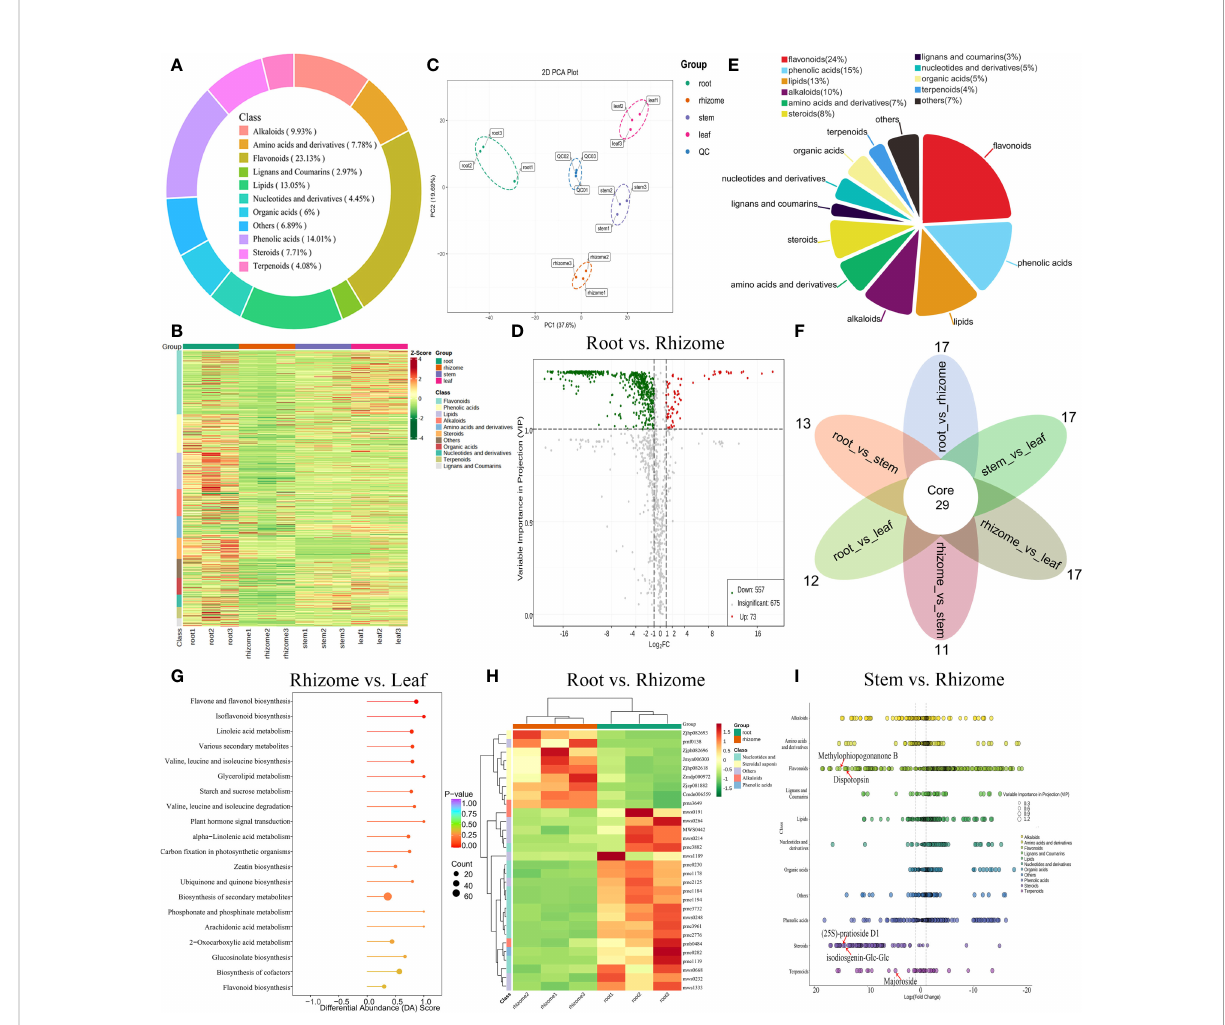
FIGURE 2 Metabolic pro fi les of P. cyrtonema in different tissues. (A) Ring diagram of metabolite component categories. (B) HCA of metabolites. (C) PCA of roots, rhizomes, stems, and leaves. (D) Volcano diagrams showing the DAMs in the root vs rhizome group. (E) Pie chart showing the percentage of each class of DAMs. (F) Venn diagram of DAMs shared among all groups. (G) Enrichment analysis of DAMs in the rhizome vs leaf group. (H) Top 30-fold changes in DAMs in the root vs rhizome group. (I) Scatter plot of DAMs in the stem vs rhizome